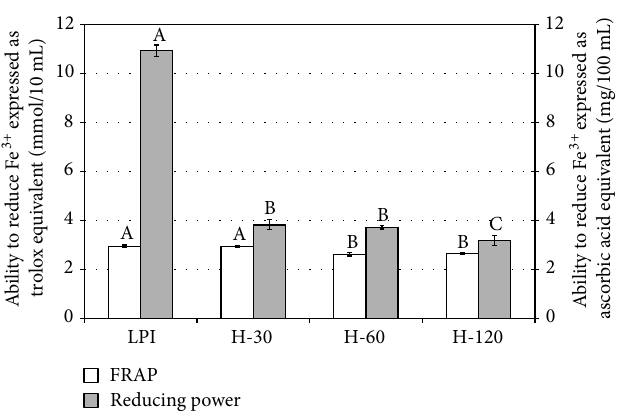
Figure 6: Antioxidant activity expressed as ability to reduce Fe 3+ . The presented values are means ± standard deviations ( n = 3 ). Values with di ff erent letters (a – c) in plot bars for the same method di ff er signi fi cantly at P ≤ 0 : 05